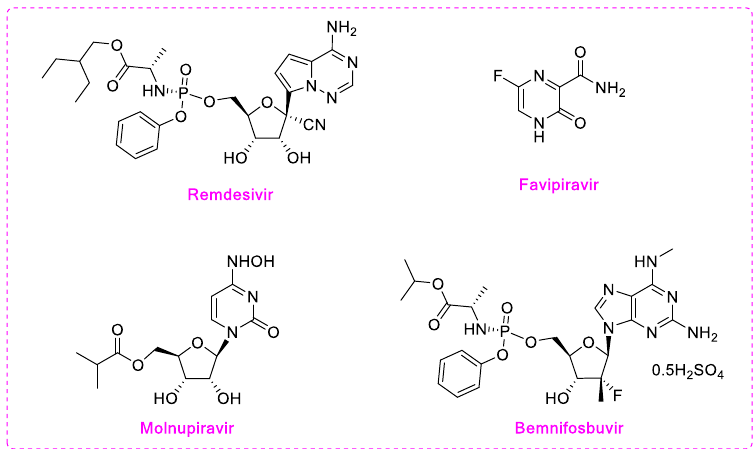
Figure 1. Structures of current nucleoside or nucleoside precursors RdRp inhibitors.